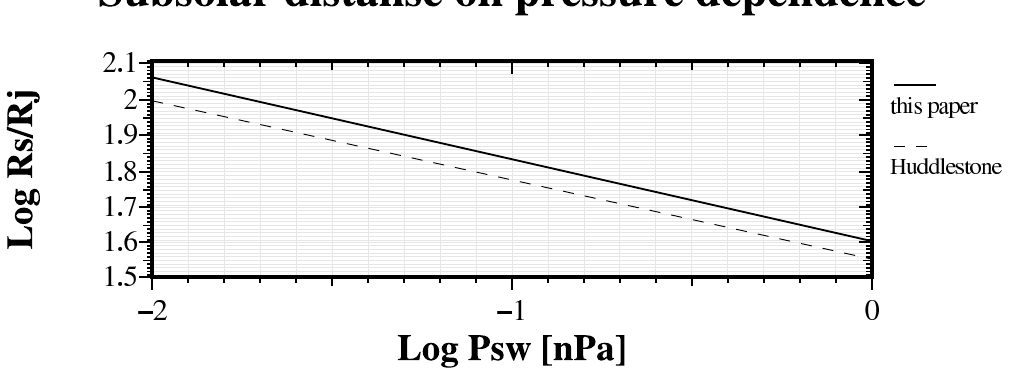
Fig. 11. Comparison of the solution of Eq. (24) (upper line) with the results by the analysis of Huddlestone et al. (1998) based on Voyager 1 and 2 data (bottom